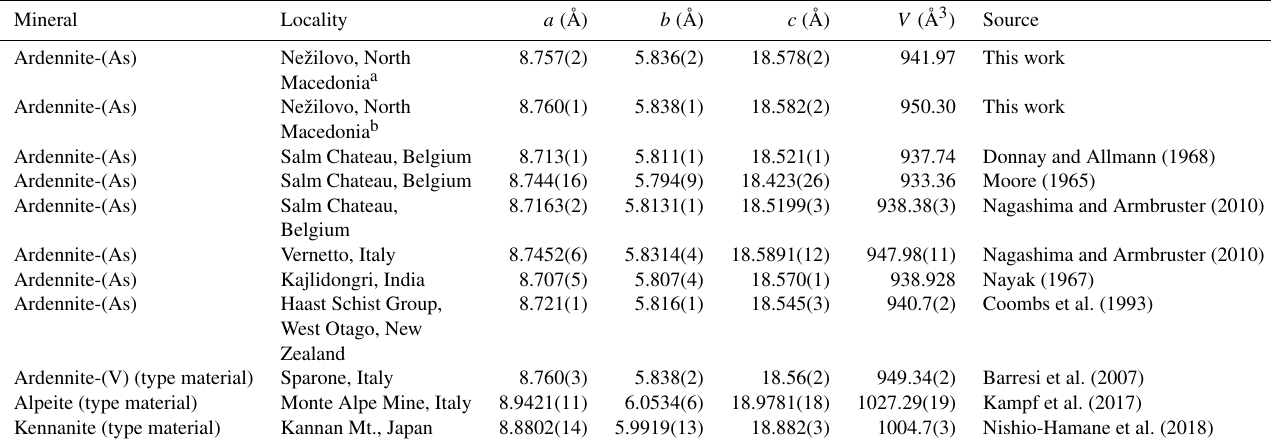
Table 3. Unit cell dimensions of ardennite-(As) and related minerals. Mineral